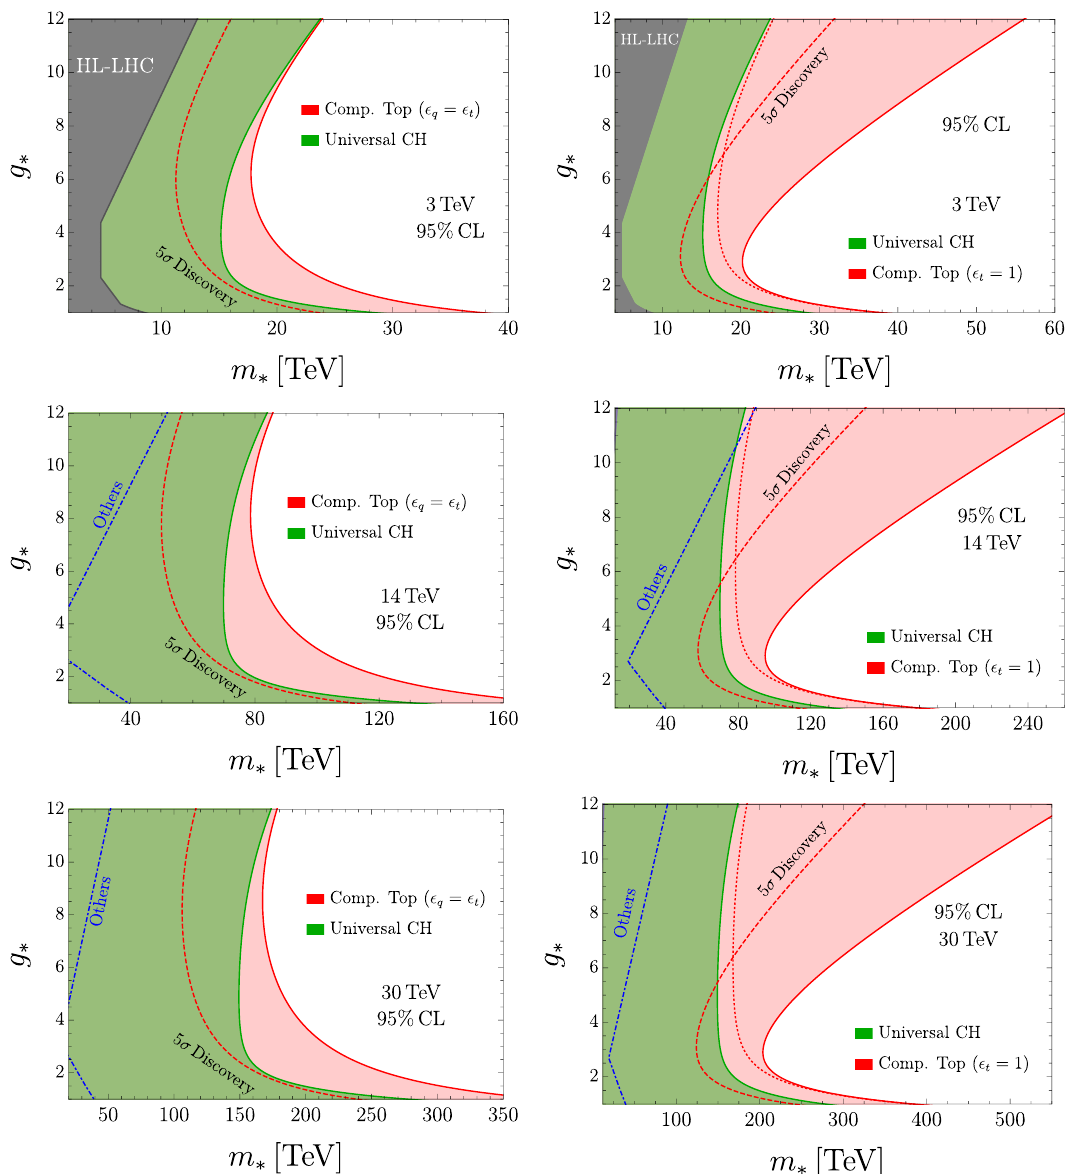
Figure 17. The same as figure 11 for various collider energies. The blue line on the equally- composite (left panels) projections are taken from [87], while on the right-handed composite top scenario are taken from